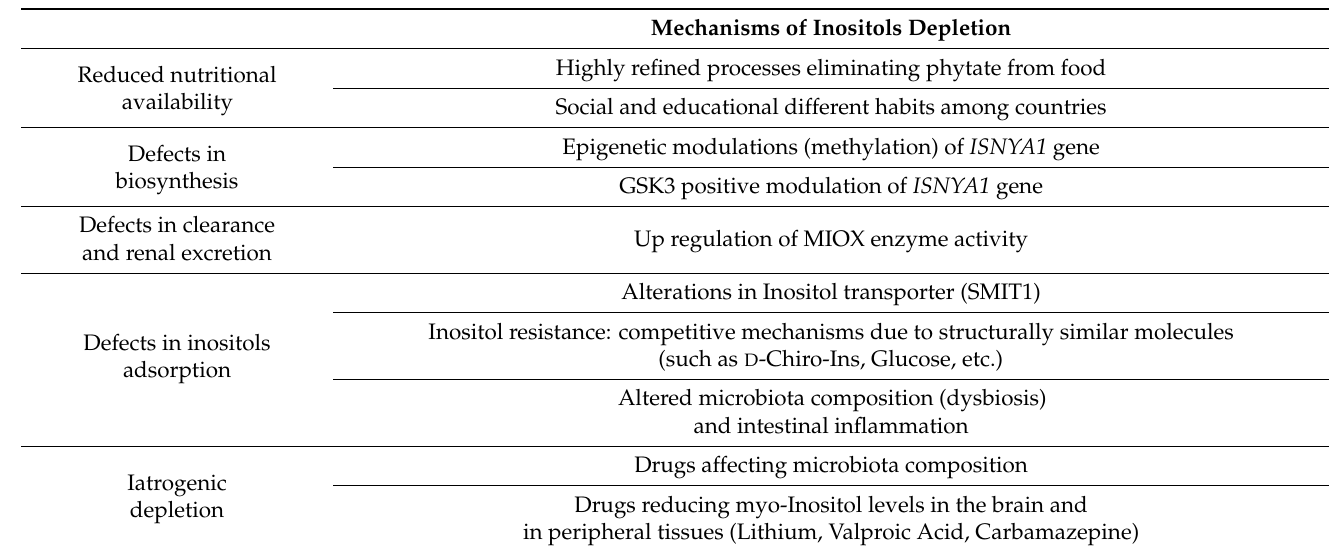
Table 1. Mechanisms involved in inositols